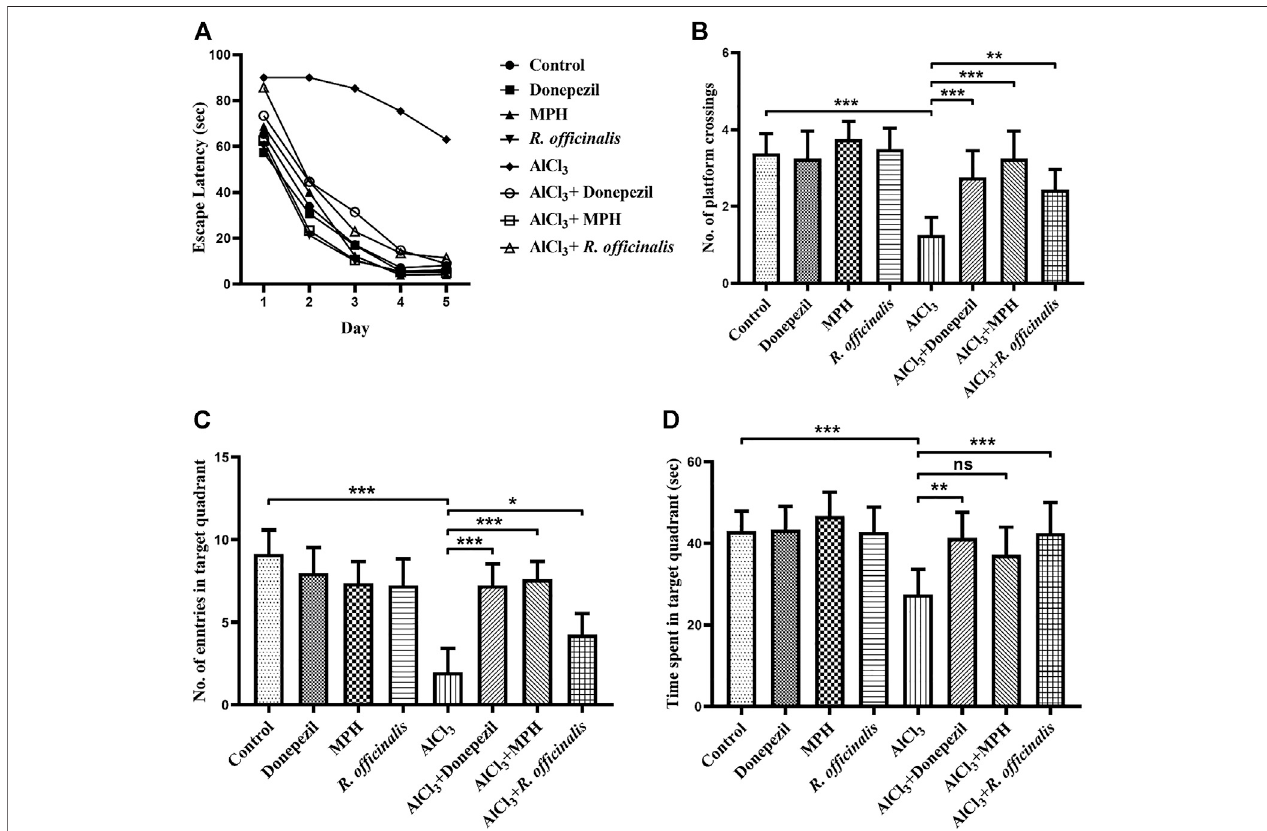
FIGURE 2 | Effects of Donepezil, MPH, and R. of fi cinalis on spatial memory in AlCl 3 -induced mice models using the Morris water maze test. (A) Graph demonstrates escape latency (sec) of the experimental groups, (B) number of platform crossings by the study groups, (C) number of entries in the target quadrant, and (D) time(sec) spent in the target quadrant during the probe trial. One-way ANOVA followed by the Bonferroni comparison test (mean ± SEM) was applied to analyze the data using GraphPad Prism. n = 8. *** p < 0.001, ** p < 0.01, * p < 0.05.